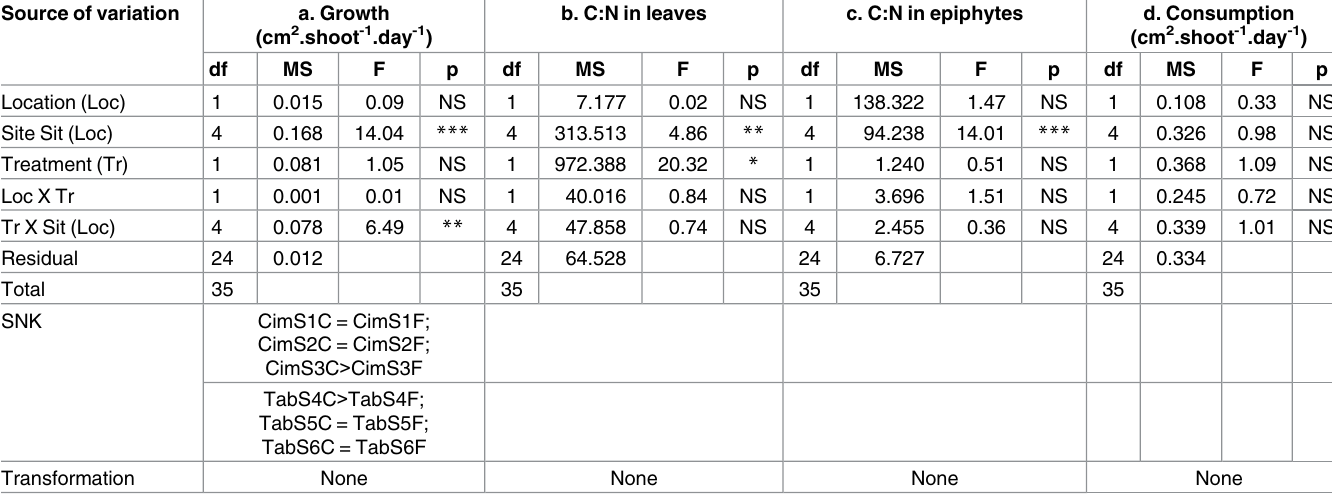
Table 1. Three way ANOVA results for: (a) growth rates; (b) nutrient content (C:N ratio) in leaves; (c) in epiphytes; and (d) consumption rates showing differences due to investigated factors “Location” (fixed and orthogonal factor with 2 level), “Site” (random and nested in “location” with 3 levels) and “Treatment” (fixed and orthogonal factor with 2 levels) considering “plot” as a replicate. (n = 3 fertilized/control plots per site; 9 fertilized/ control plots per location). Source of